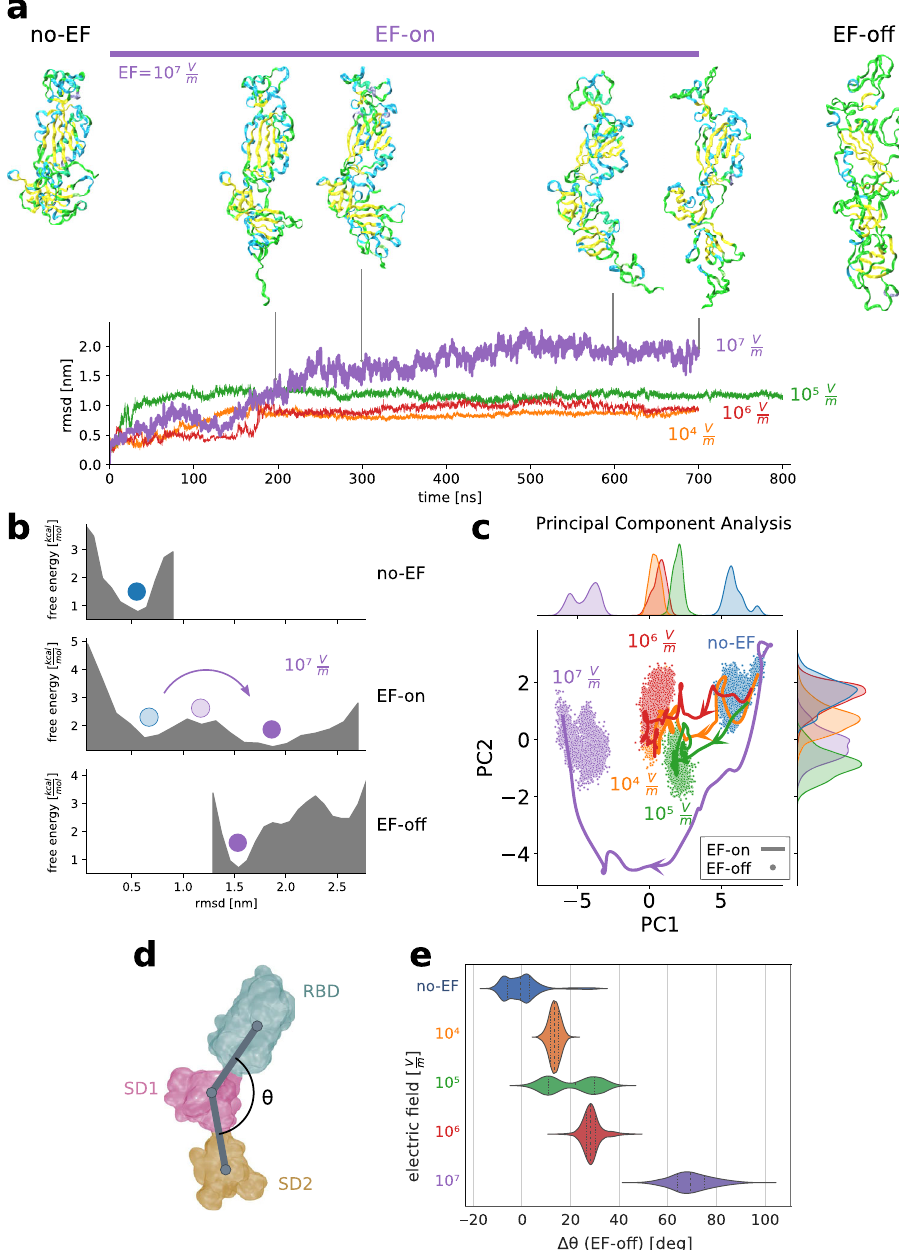
Fig. 2 Electric fi elds are able to induce global conformational changes in the spike glycoprotein, affecting the stability of folding states. a , b EF driven major shape changes occur in the different subunits and between subunits of the S protein. a Snapshots of the studied fragment of S under an EF of 10 7 V m − 1 at 0ns (initial thermalised stable conformation), 200, 300, 600 and 700ns, and after EF-off (see text) dynamics during 200ns. The orientation of the protein is the same in all fi gures. Trajectories for different electric- fi eld strengths are quanti fi ed through the root-mean-square-displacement (RMSD) with respect to the initial structure. Snapshots in a correspond to different times along the EF-on trajectory. b Electric fi elds modify the free energy landscape enabling the protein to overcome potential barriers. Estimated free energy landscape along the thermalisation (no-EF-), EF-on- and EF-off trajectories (see Methods). The blue and the light blue dots identify the energy minimum of the initial structure before and during EF application, respectively. Purple dots correspond to the new minimum reached under the EF, which remains stable after switching off the EF. c Principal component analysis (PCA) reveals the existence and stable nature of new states after EF application (see Methods). Discretised trajectories of the EF-on and EF-off runs projected onto a plane de fi ned by the two principal components (PC1, 20% of variance; and PC2, 8.2% of variance). Curves on the upper and right axis show the density of points along PC1 and PC2, respectively. Once the S protein has found a new equilibrium basin, which is different for each EF intensity, no return to the initial state occurs after switch-off of the EF. For clarity of representation, curves in the EF-on trajectories are low-pass fi ltered using a Gaussian kernel (standard deviation 10ns). d Field-induced conformational states can be characterised by the angles formed by the vectors connecting the centroids of clustered residues. e Violin plot of the distributions of the shift 4 θ of the angle θ for different fi eld intensities (EF-off runs) with respect to a no-EF representative structure. 4 θ is suitable to describe the unfolding of the domain SD2 observed in a . In the violin plot, the central line indicates the median, while left and right lines indicate lower and upper quartiles, respectively. EF intensities are color-coded equally for all sub- fi